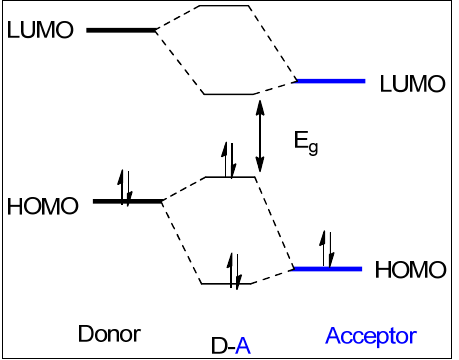
18 of 39 Figure 18. The molecular structure of incorporating a fused ring in the thiophene system. 6.3. Donor–Acceptor Alternation Approach in Conjugated Polymer This approach necessitates copolymerizing alternating strong electron-donor mono- mers with electron-acceptor monomers along the same π -conjugated system of the poly- meric chain in a so-called D–A [80]. It became clear that alternating donor–acceptor seg- ments contribute to a pull–push driving force between adjacent units in order to facilitate π -electron delocalization and the formation of a QD mesomeric structure (D-A ↔ D + = A − ) over the polymer’s main backbone, resulting in reduced optical EBG [29]. Moreover, it is assumed that ICT between the donor-HOMO and acceptor-LUMO reduces the energy EBG of the polymer, leading to a significant reduction in the EBG owing to improved interchain delocalization. The decreased EBG energy can be rationalized and explained via Molecular Orbital Theory (MO). The HOMOs of the donor and acceptor segments (Figure 19) produce two new HOMOs due to the interaction of energy levels [29]. The interaction between low energy levels leads to broadening of the valence band. Similarly,